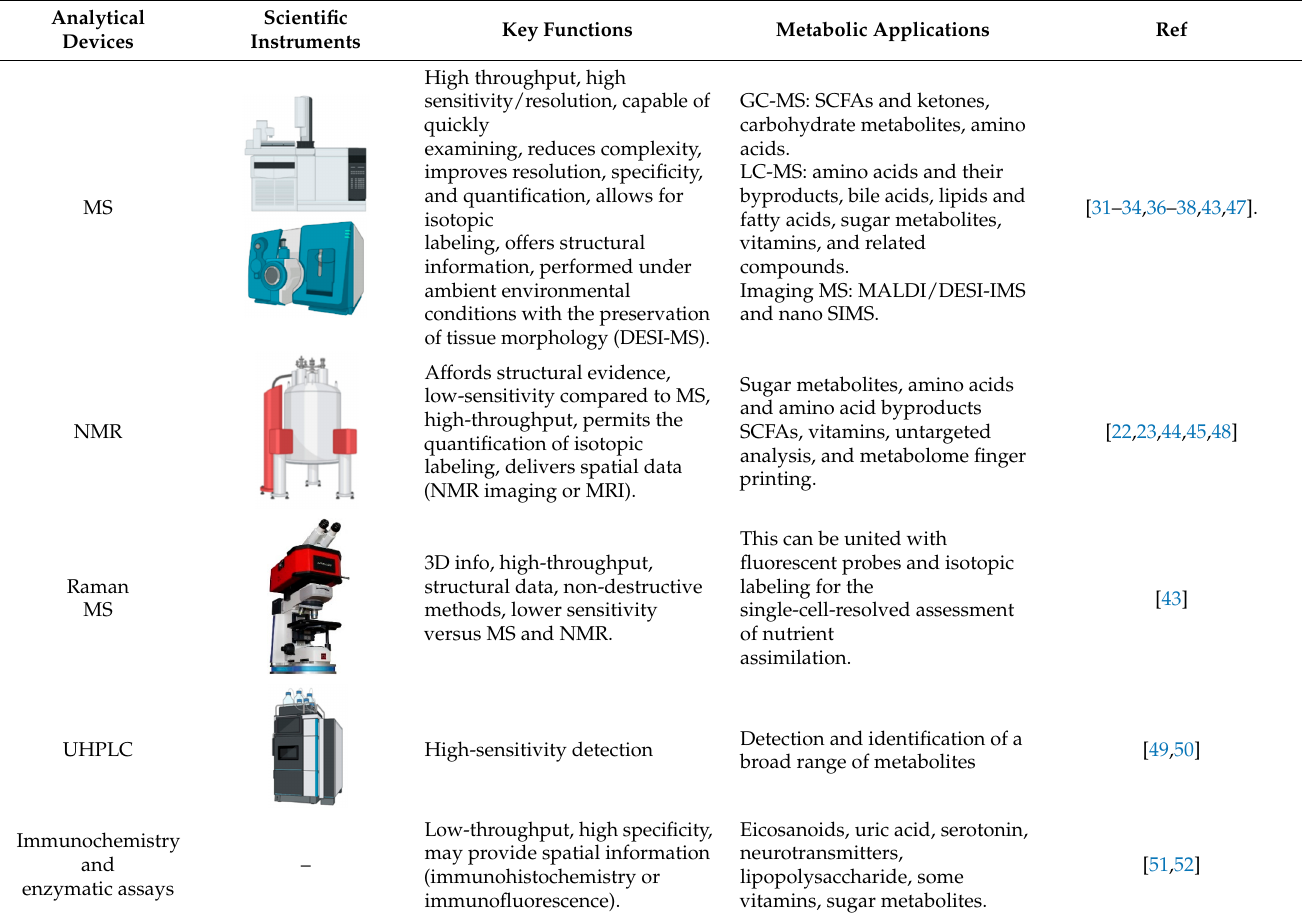
Table 1. Application, analytes, detection, and comparison of top analytical devices for metabolomics scientific technology.